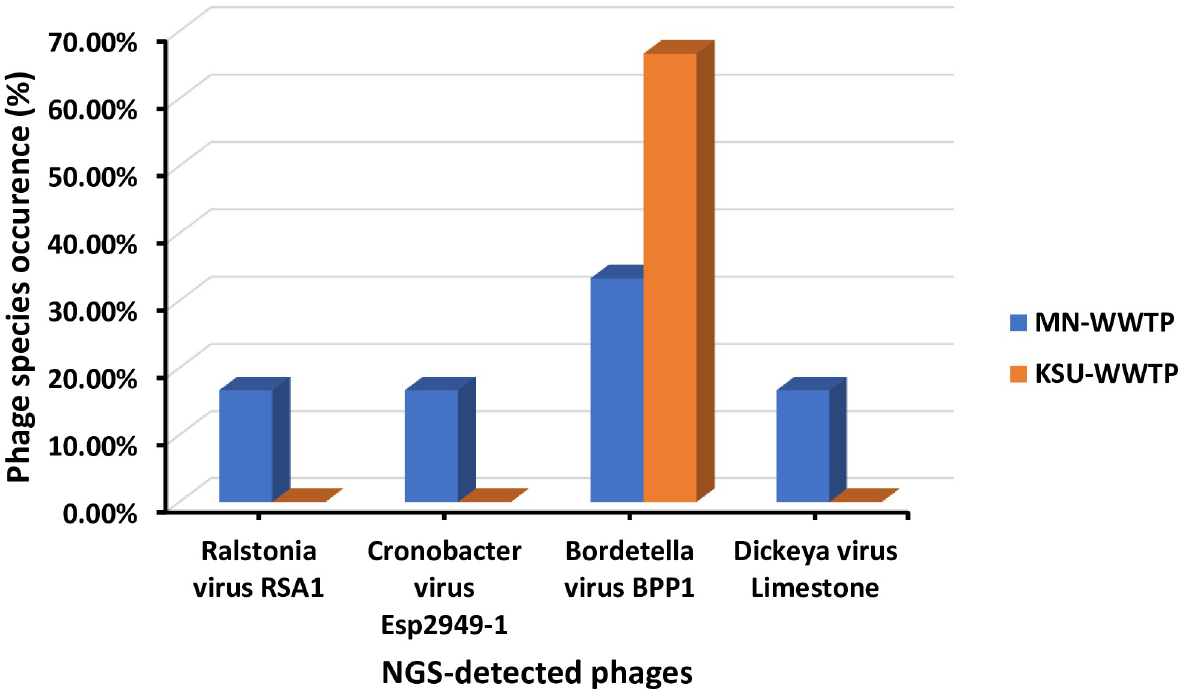
Fig 7. Occurrence of bacteriophages in NGS samples in